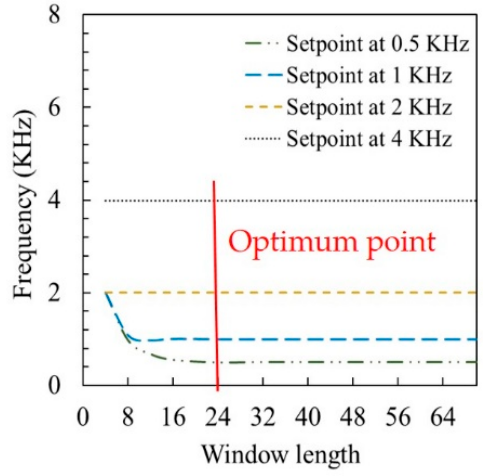
Figure 8. Effect of the window length in generating a spectrogram on the measured peak frequency. Figure 9a represents an example of the Doppler frequency classification for the proposed technique in one measurement channel, showing the processing system on single ‐ phase flow. The Doppler frequencies observed from the peak on the spectrogram are only influenced by particles because the Doppler amplitude of each time location point is lower than the threshold value. Figure 9b shows the spectrogram in two ‐ phase bubbly flow conditions. The frequency data at points a, and c can be defined as the Doppler frequency of a particle due to Doppler amplitude being lower than the threshold value. On the contrary, at point b, the Doppler frequency belongs to a bubble because Doppler amplitude is higher than the threshold value.